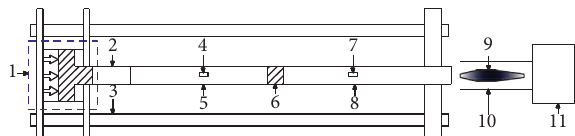
Figure 1: Structure diagram of the test load: (1) Pressure loading unit; (2) Buffer bar; (3) Support; (4) Strain gauge A2; (5) Trans- mission bar; (6) Rock specimen; (7) Strain gauge A1; (8) Incident bar; (9) Heterotype impact hammer; (10) Launch cavity; (11) Gas